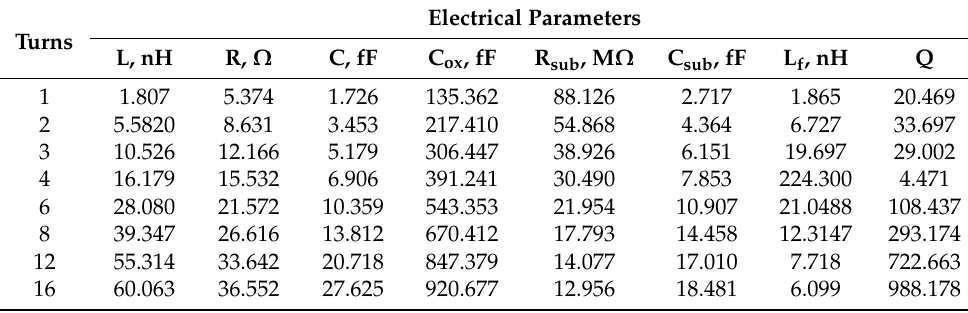
Table 2. Results of analysed square spiral inductors at 10 GHz.